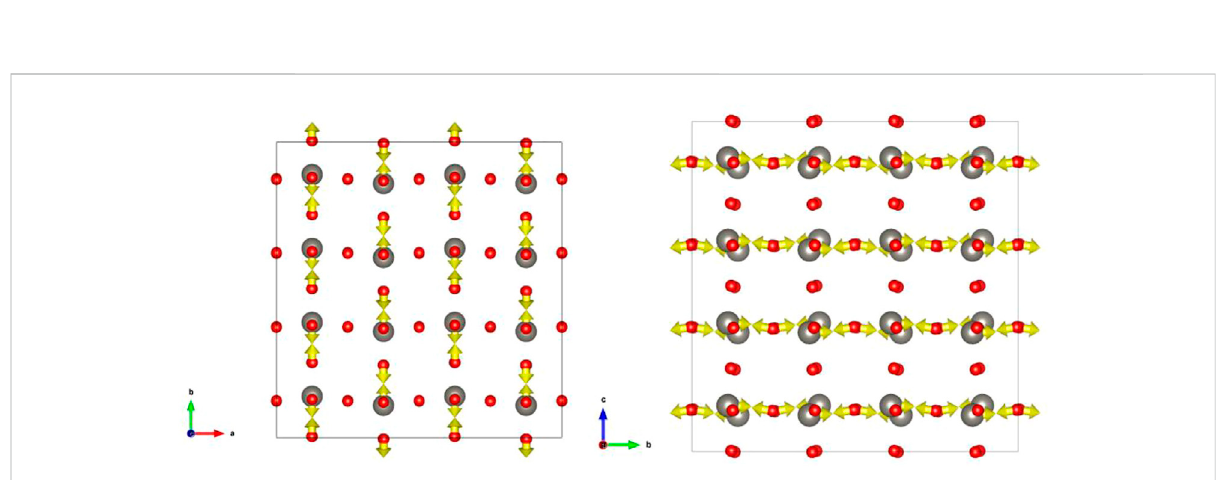
(Left)Panoramicviewofthedifferencebetweentheexcitedstatecon fi gurationofST2andthechargedensityoftheupspininthegroundstate; (Middle) only the atomic surface of the excited surface; and (right) atomic displacement from ST1 to